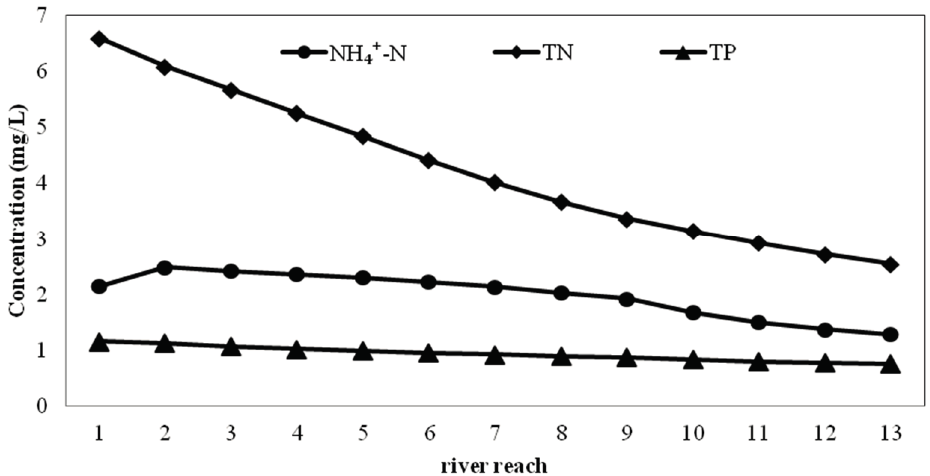
Figure 5. Simulation results of the water quality of Tianlai River under present conditions Simulation of water quality with ecological material at different densities.